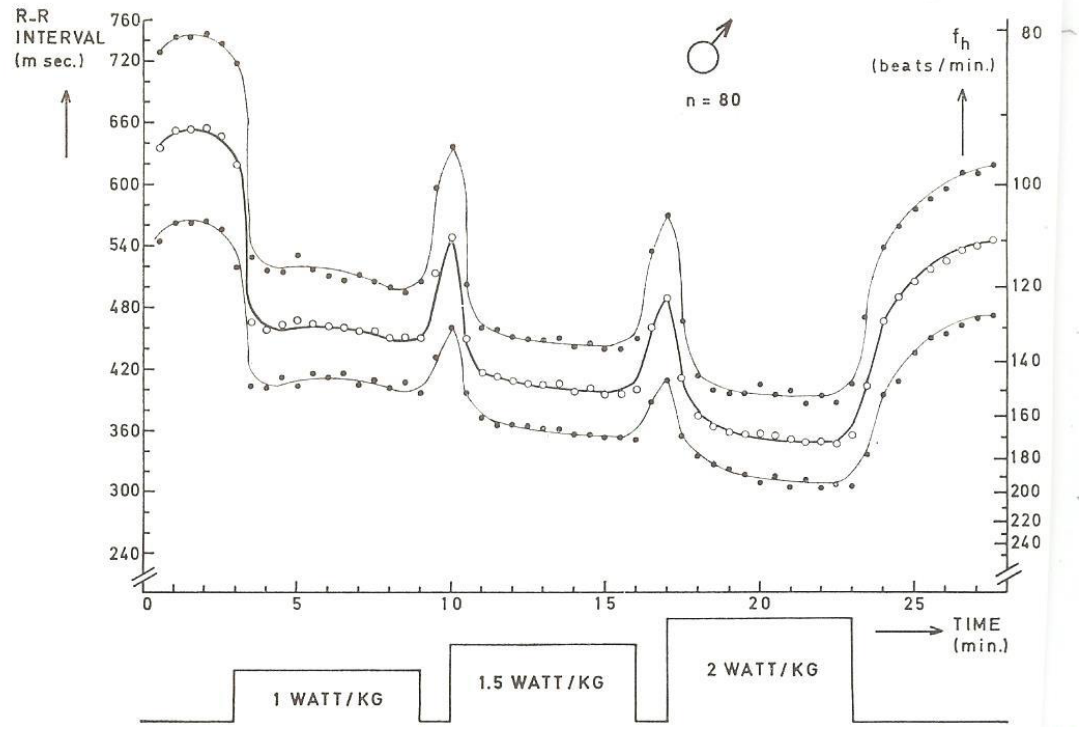
Figure 1. Mean (open symbols) and standard deviation (black symbols) of the heart rate (beats /min) of all subjects for every 30-s period [2].